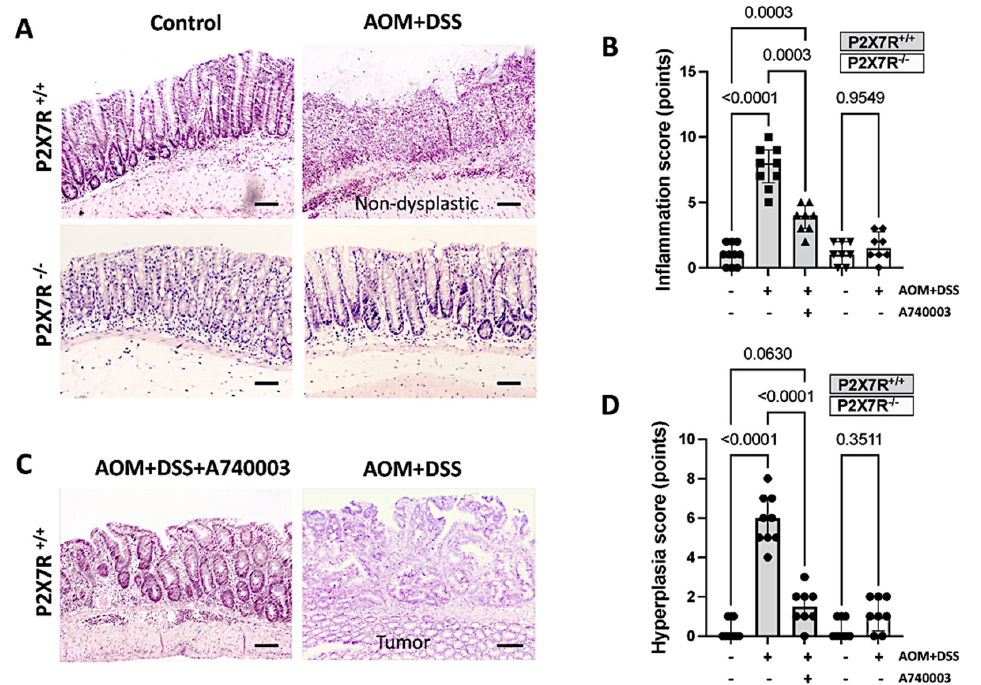
Figure 2. P2X7R blockade attenuates colonic injury in the AOM/DSS-treated mice. Histopathological analysis by hematoxylin and eosin (HE) staining of the colon shows the typical inflammatory